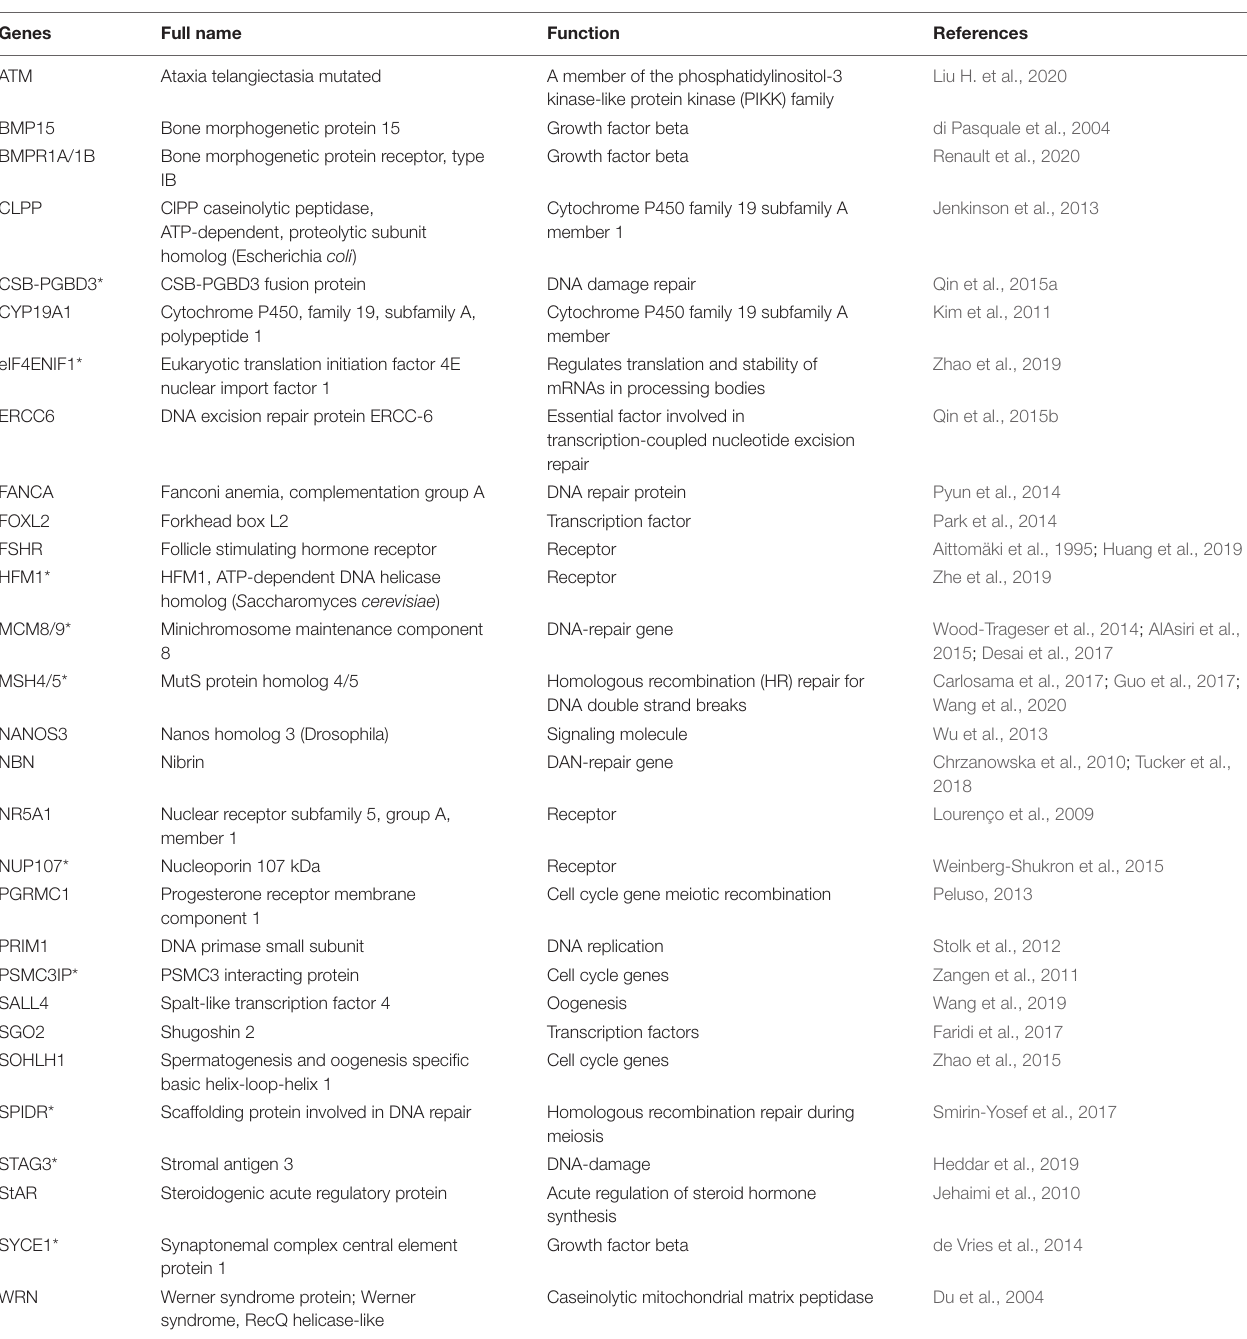
TABLE 3 | Common POI-related genes in humans and